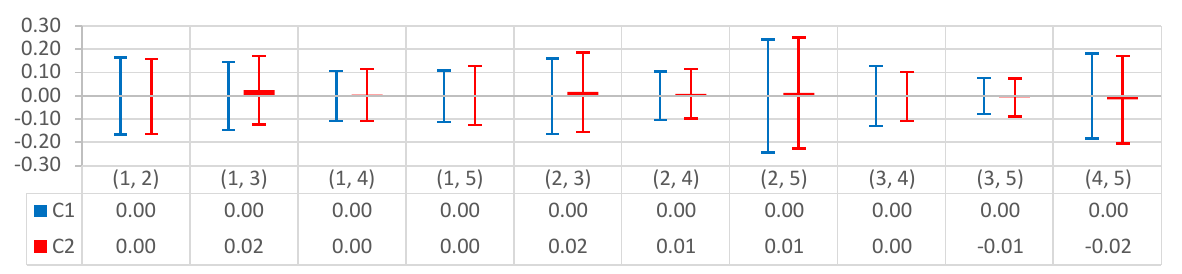
Figure 5. Difference between the baselines computed in calibration 1 (C1) and in calibration 2 (C2) ± MAD. The comparison is based on the values obtained from the filtered dataset. Values expressed in